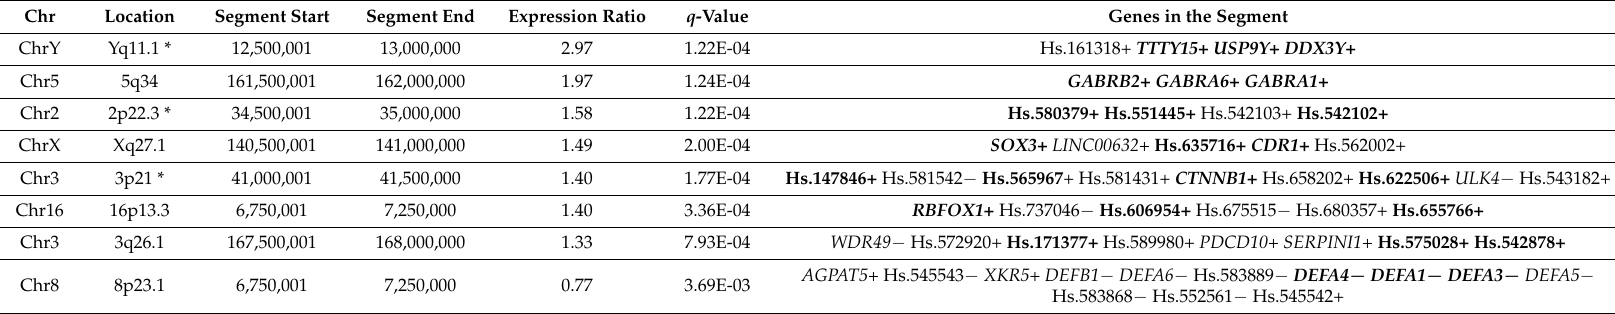
Table 3. Chromosomal segments statistically significant in TRAM “Map” mode analysis of male SN PD patient sample vs. female SN PD patient samples (TRAM